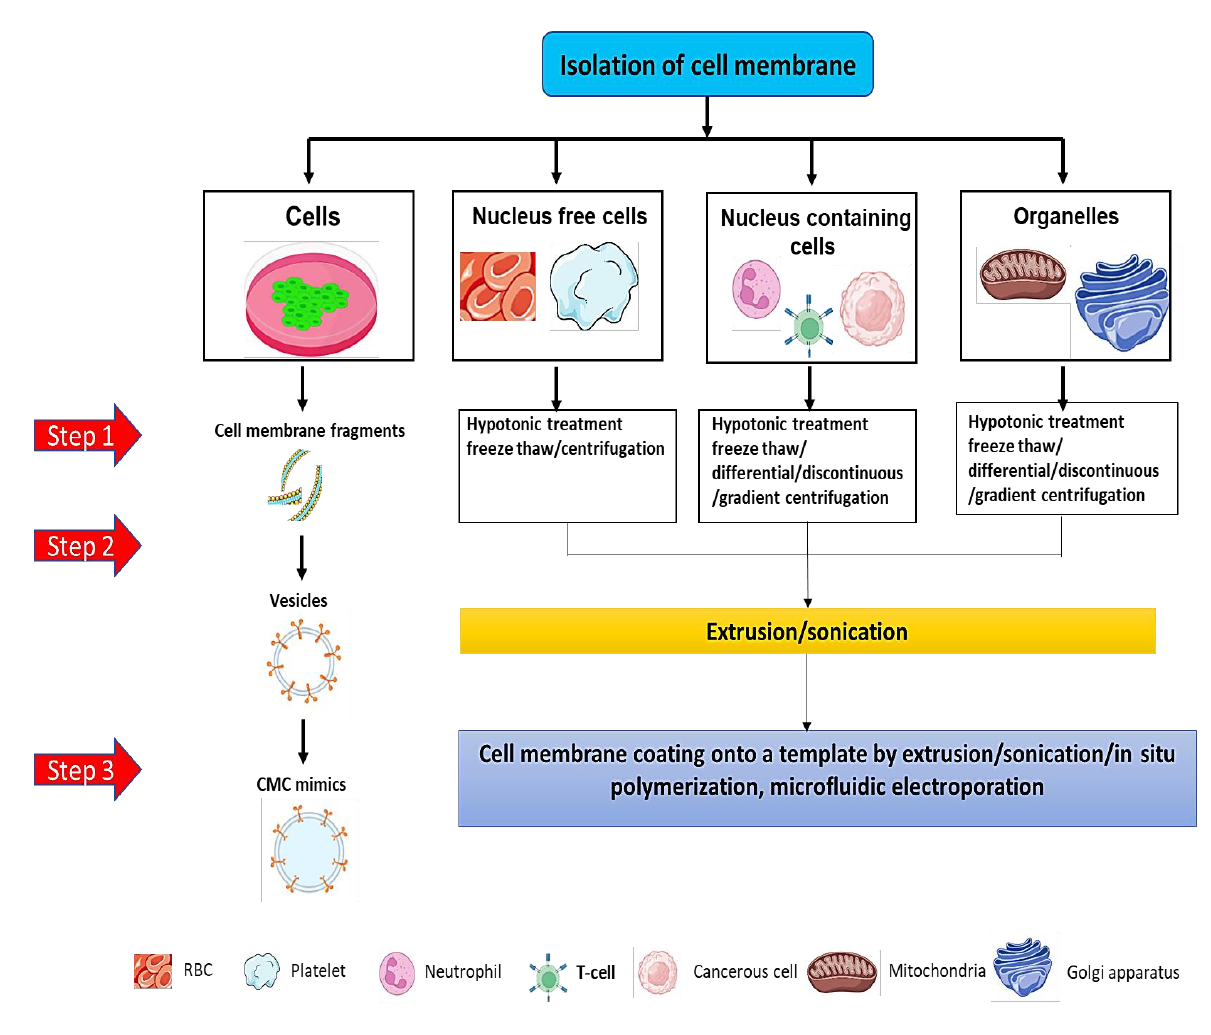
Figure 3. Isolation of the cell membrane from different types of the cells such as nucleus-containing cells, nucleus-free cells, and organelles.